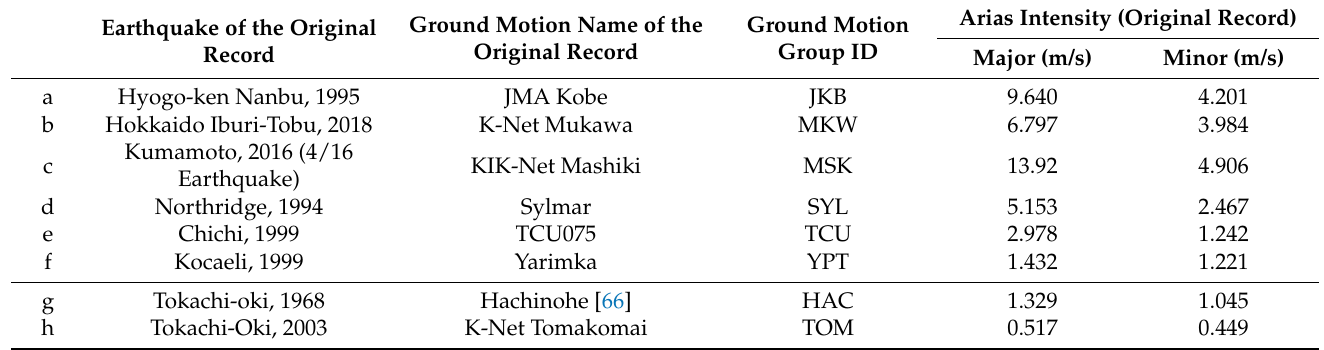
Table 1. List of ground motion groups investigated in the present